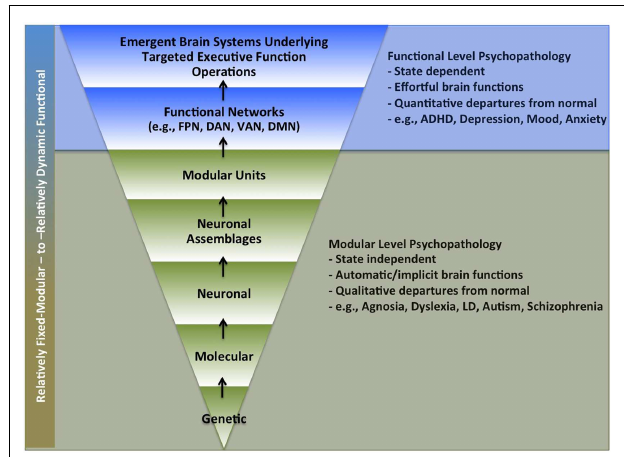
FIGURE 1 | Possible levels of impairment underlying psychiatric disorders . Legend : multiple levels of brain function levels that might underlie brain function pathology in psychiatric disorders. Lower section (in green) highlights levels more likely to involve automatic processing (i.e., that do not require self-directed effort). Upper section (in blue) highlights levels more likely to require active volitional effort. FPN, fronto-parietal network; DAN, dorsal attention network;VAN, ventral attention network; DMN, default mode network; LD, learning